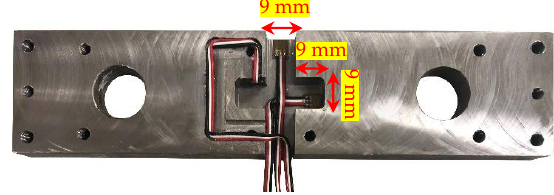
Figure 9. Simulation results for ( a ) X -axis strain results from the force in the X direction , ( b ) Y -axis strain results from the force in the Y direction, and ( c ) Z -axis strain results from the force in the Z direction.